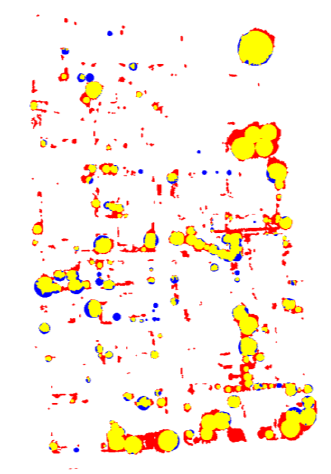
Figure 8. Trees classification (correctly classified as yellow, misclassified as red, missing as blue)